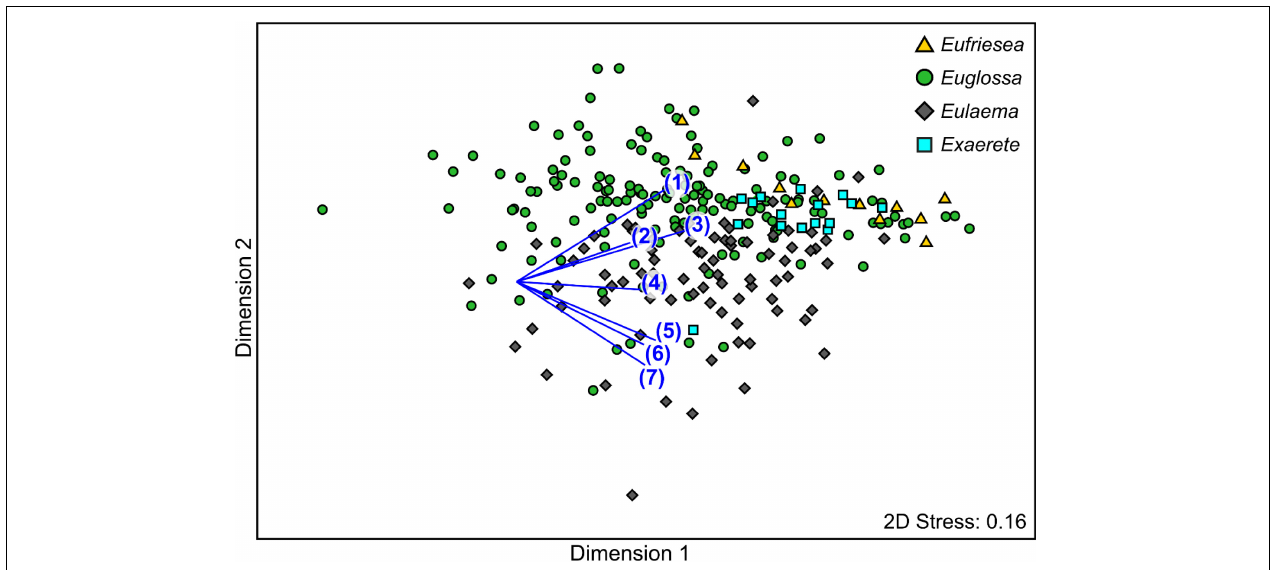
FIGURE 2 | Non-metric multidimensional scaling (nMDS) representation of antennal responses of different euglossine genera to 23 compounds, based on a Bray Curtis similarity matrix (standardized responses in percent). The single dots represent single bee individuals. Vectors represent the Pearson correlations for compounds most responsible for the dissimilarity in antennal response profiles between genera as indicated in a SIMPER analysis: (1) methyl o -anisate, (2) α -copaene, (3) eugenol, (4) β -ionone (5) ipsdienol, (6) methyl salicylate, (7) ( − )-( E )-carvone epoxide.